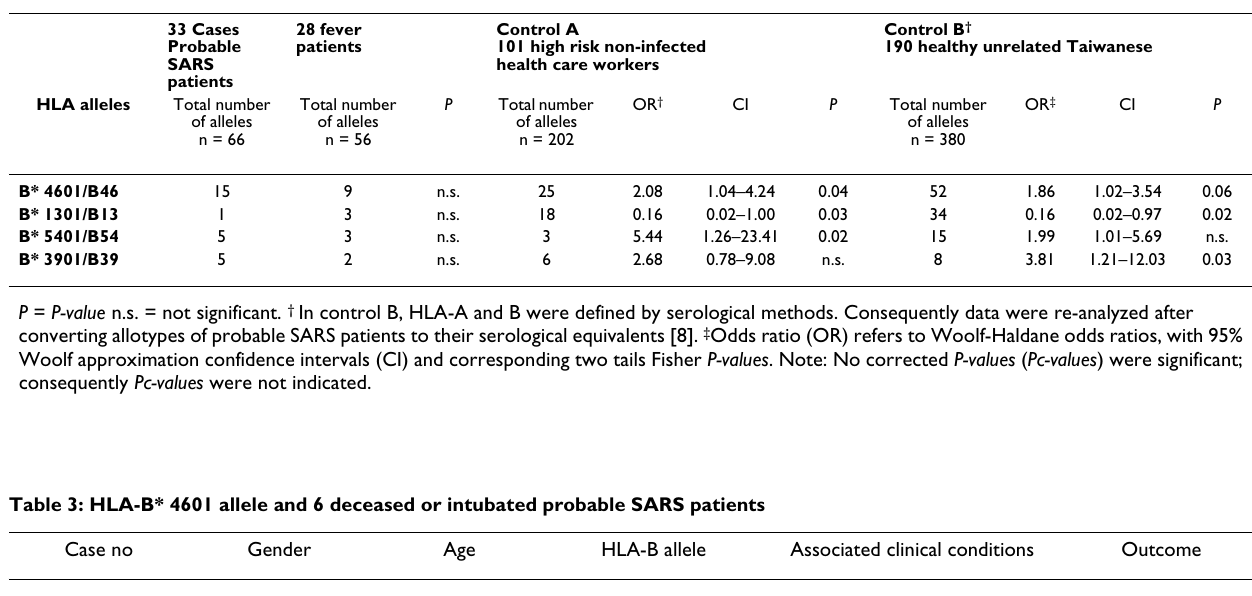
Table 2: Allele odds ratios analysis between probable SARS patients and other groups